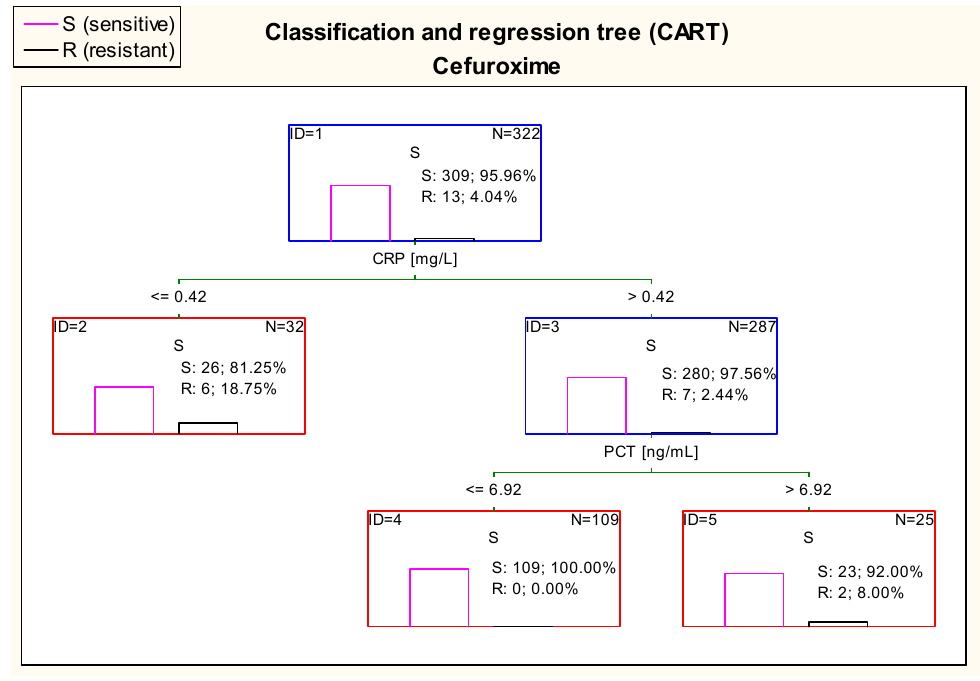
Figure 13. Classification and regression tree (CART) for resistance of Escherichia coli to cefuroxime created on the basis of inflammatory